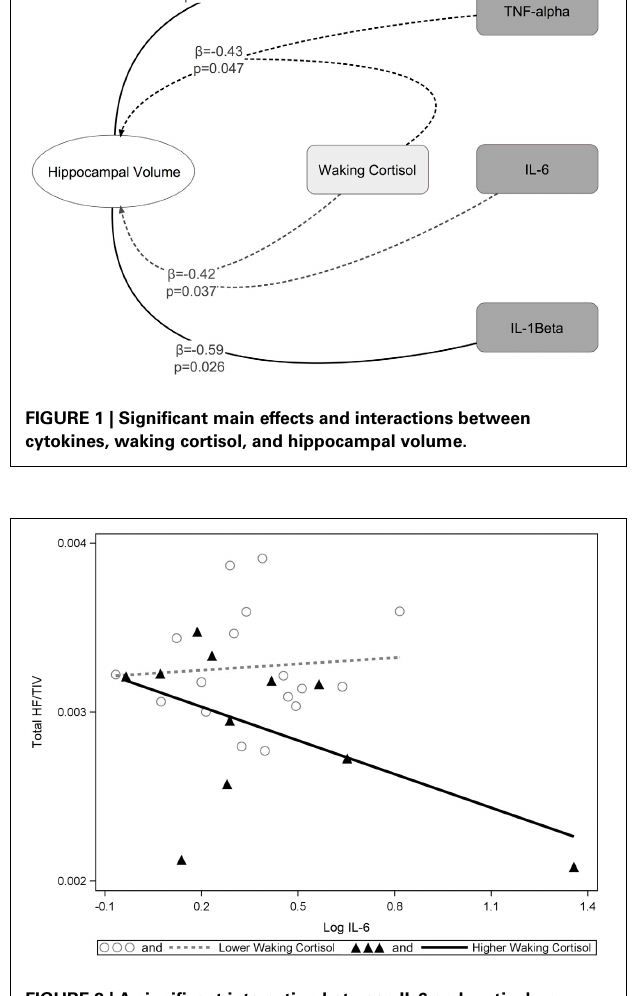
FIGURE 2 | A significant interaction between IL-6 and cortisol on hippocampal volumes. Higher waking cortisol and concurrently high levels of IL-6 are associated with smaller hippocampal volumes. “Lower” and “higher” waking cortisol levels are displayed as a median split to allow the visualization of the multiple regression results. However, continuous variables were used in all multiple regressions models.